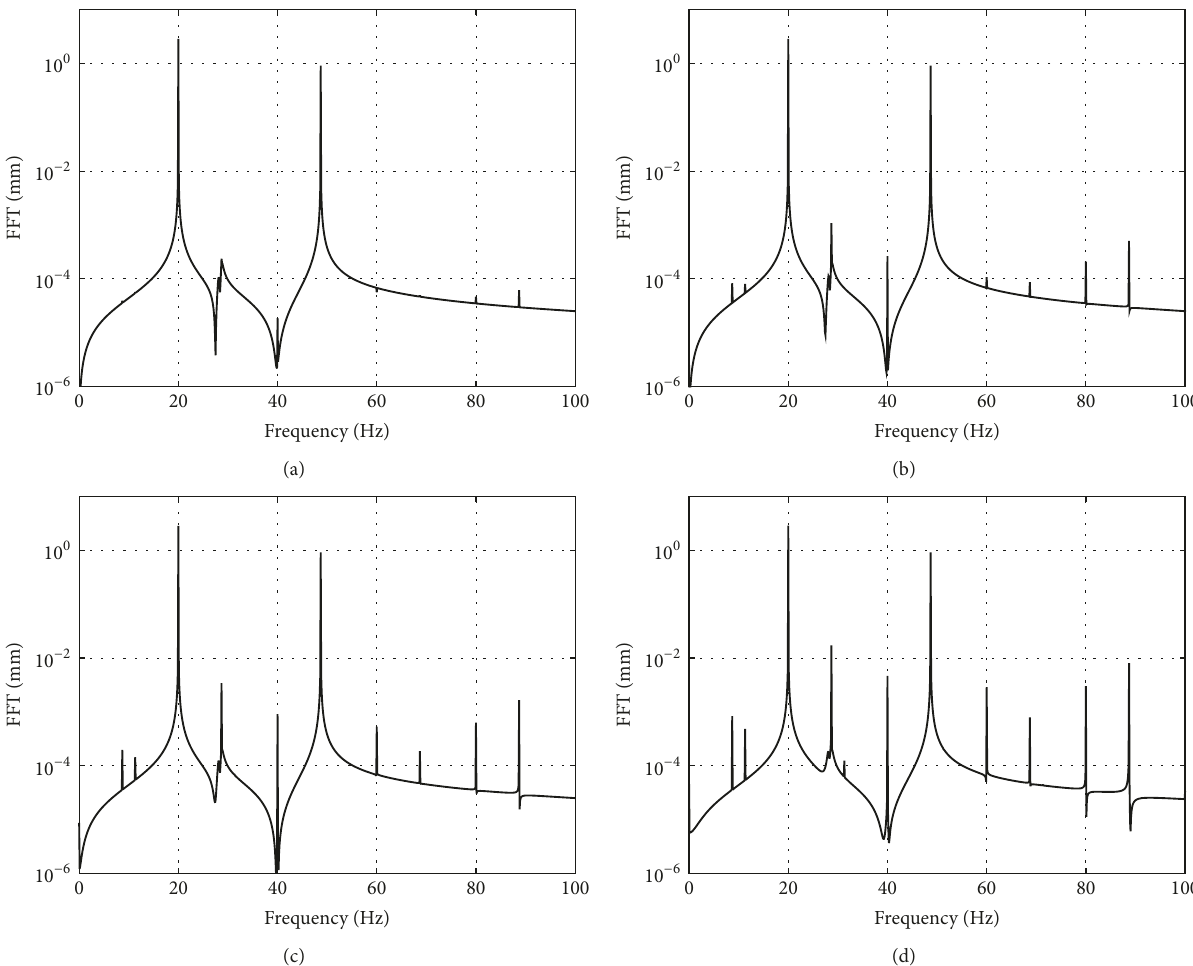
Figure 5: FFT of the system vibration responses at node #8 when excited by the diagnostic frequency of 48.7 Hz at node #4 (rotating speed of 1200 rpm): (a) 1% crack depth; (b) 3% crack depth; (c) 5% crack depth; (d) 10% crack depth.